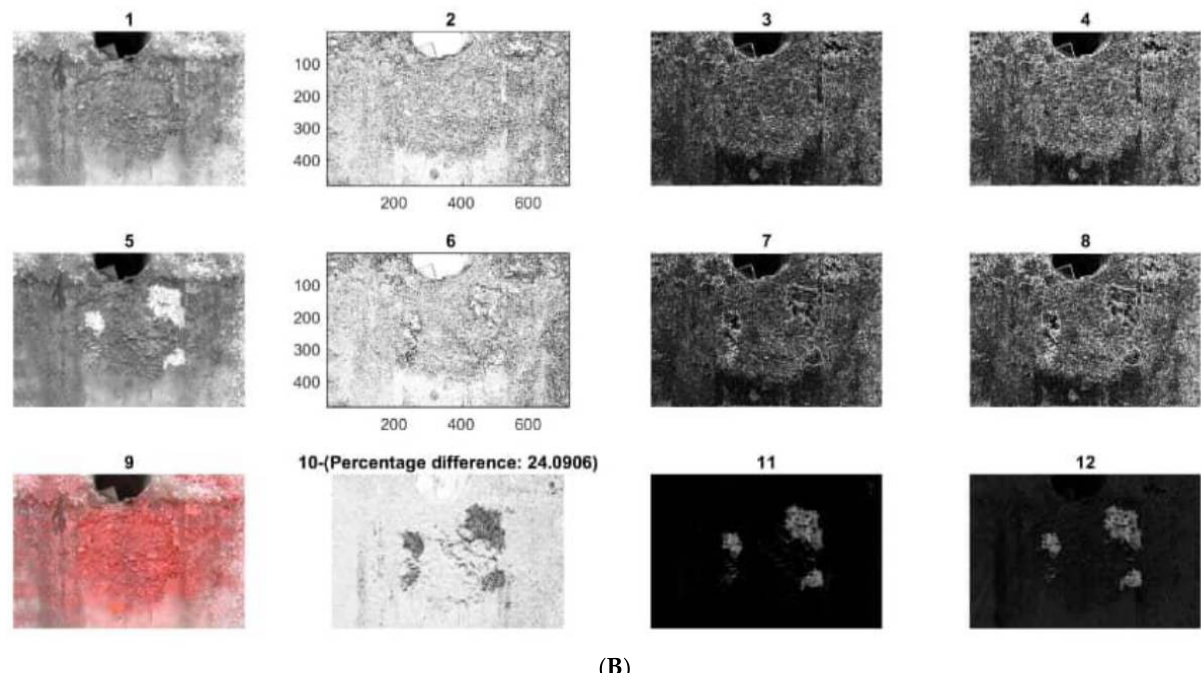
Figure 5. ( A ) Surface concrete with a minor defect. ( B ) Surface concrete with a major defect.